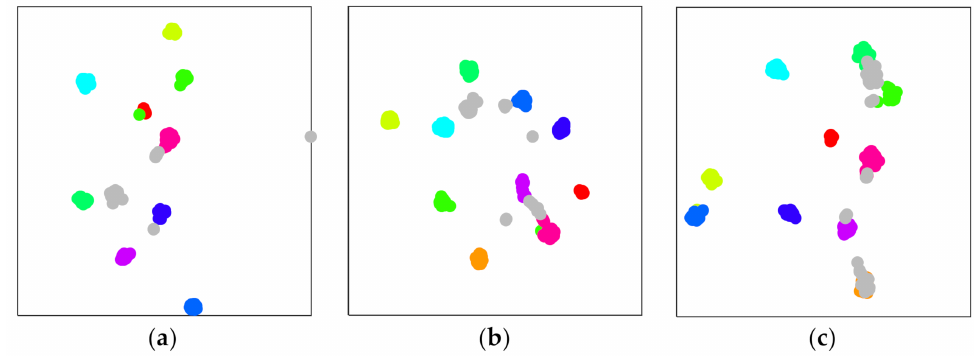
Figure 8. Plots of features following dimension reduction. Datasets contain 10 KKC and 2 UUC devices ( C KKC = 10, C UUC = 2). Colorful dots represent KKC device features, while gray ones